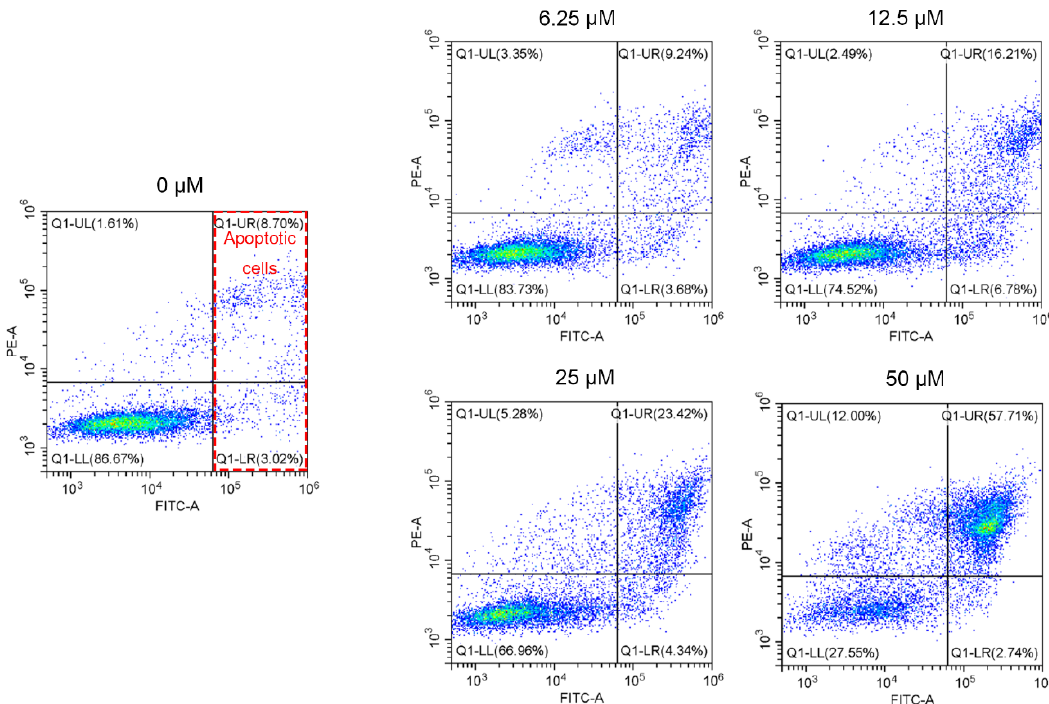
Figure 3. 2-O-Caffeoyl alphitolic acid-mediated apoptosis in HCT116 cancer cells treated with different concentrations of 2OCAA. 2OCAA-mediated apoptosis significantly increased the proportion of apoptotic cells relative to that in the untreated control cells. The quadruplicate plot represents early apoptosis (annexin-V+ and PI − ) and late apoptosis or necrosis (annexin-V+/ − and PI+) stages.